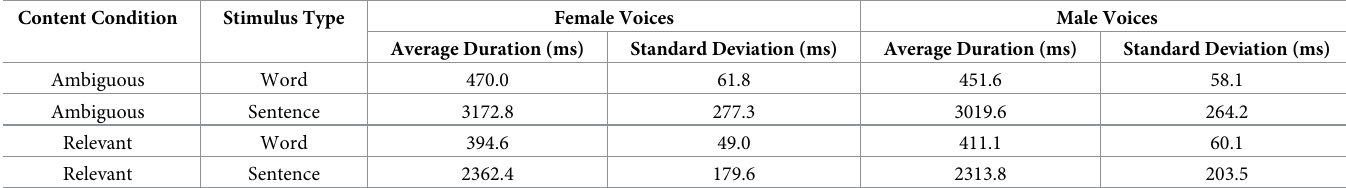
Table 1. Average stimuli duration per content condition and stimulus type.